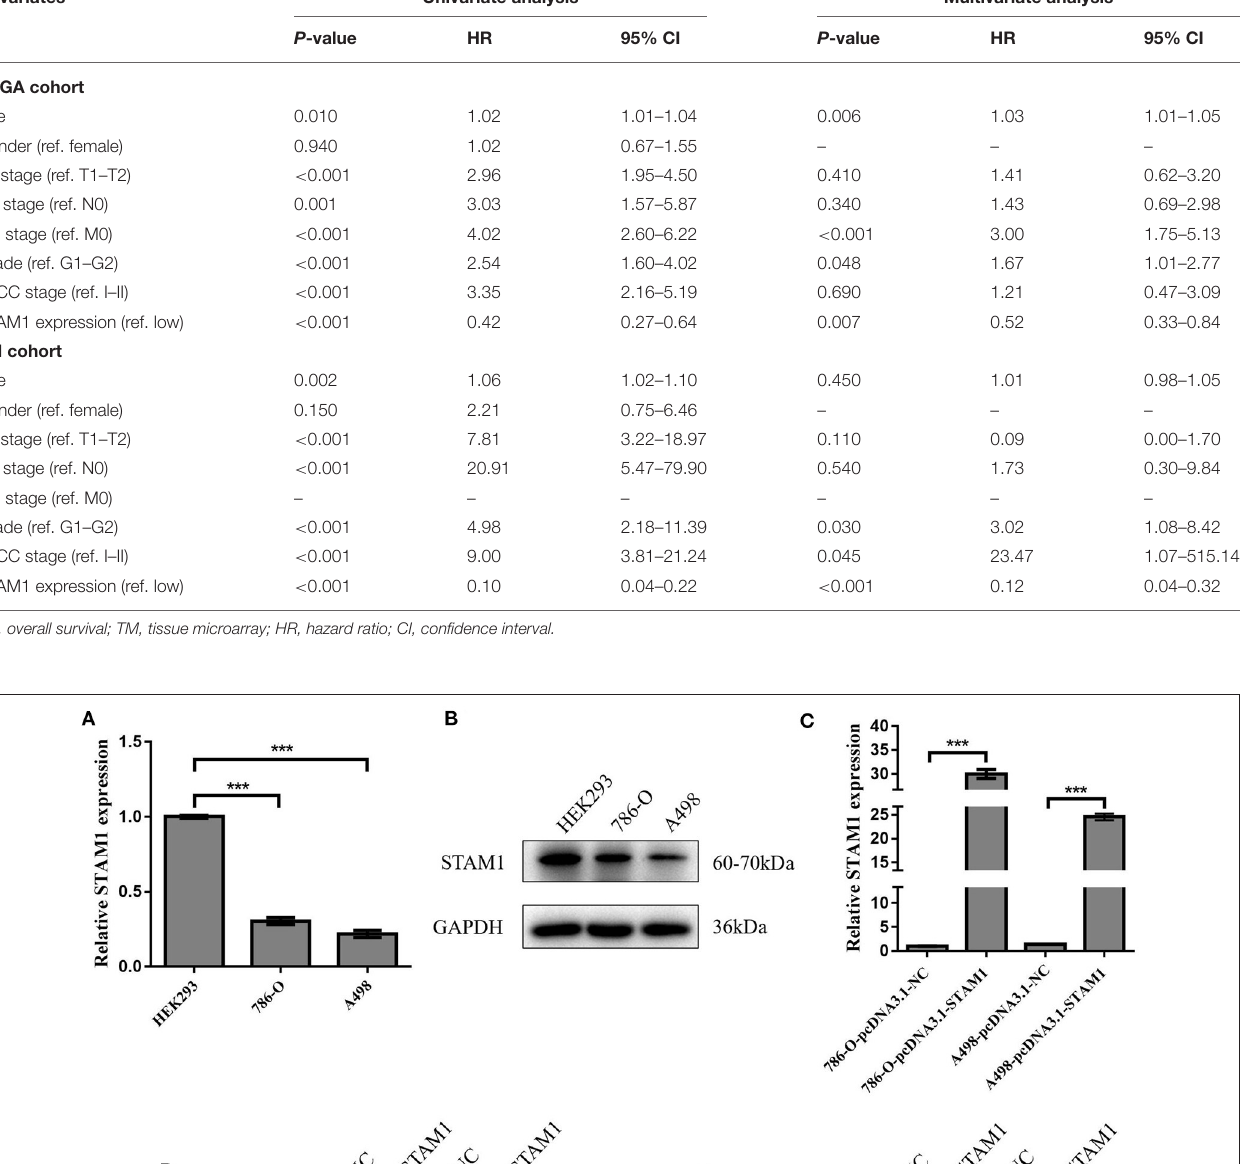
TABLE 2 | Univariate and multivariate Cox logistic regression analyses of OS in The Cancer Genome Atlas (TCGA) and TM cohorts. Covariates Univariate analysis Multivariate analysis